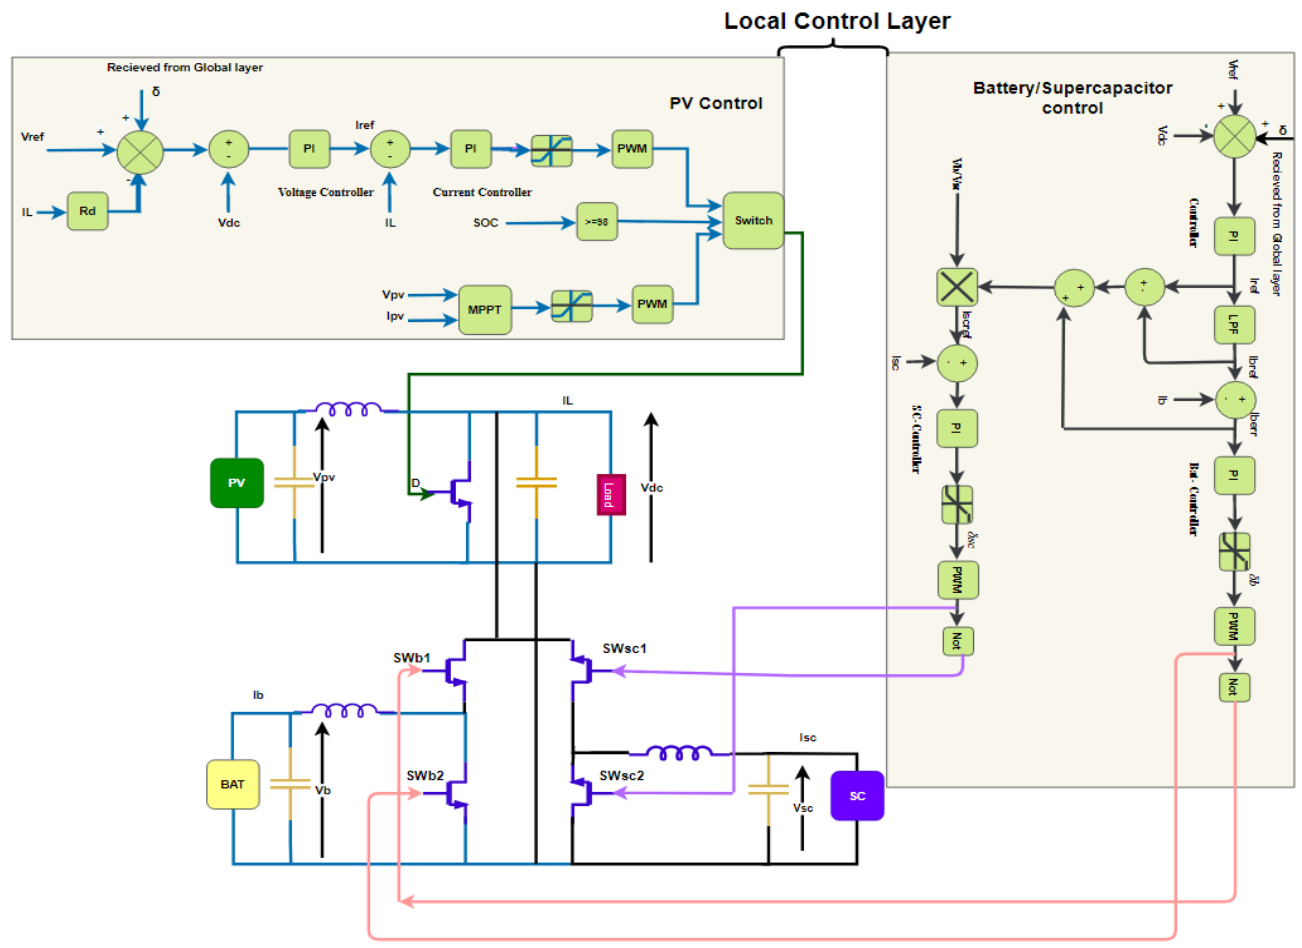
Figure 3. local control layer. Figure 3. Local control